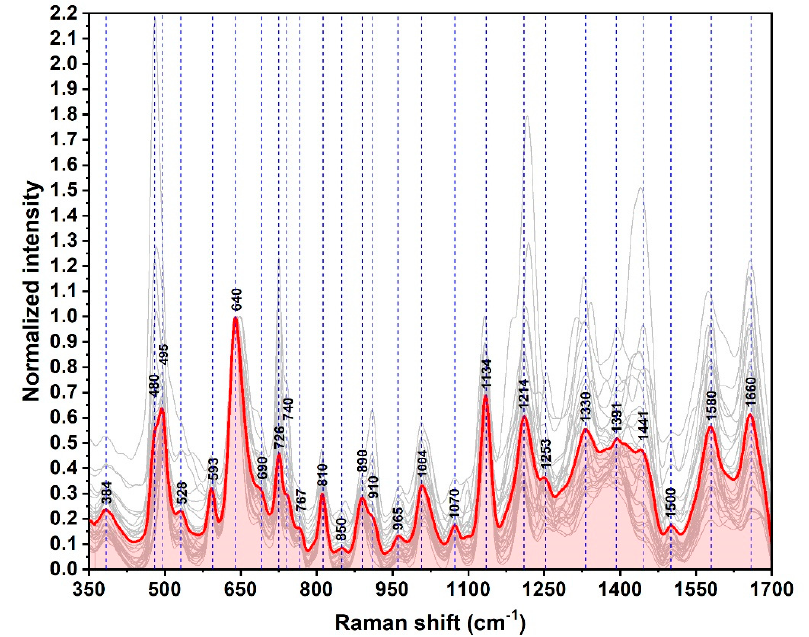
Figure 5. SER spectra of blood plasma samples obtained from BC patients ( n = 29) recorded on SSPSs using a 785 nm excitation laser. The spectra were normalized to the 640 cm − 1 peak.